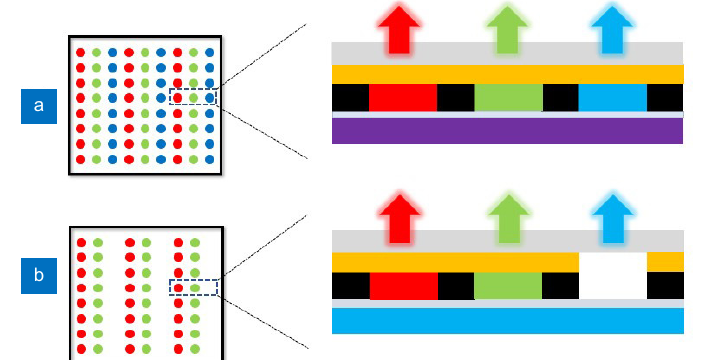
Fig. 2 | Two methods for achieving full-color by using QD CCL . ( a ) RBG three-color QDs excited by UV chips. ( b ) RG two-color QDs excited by blue